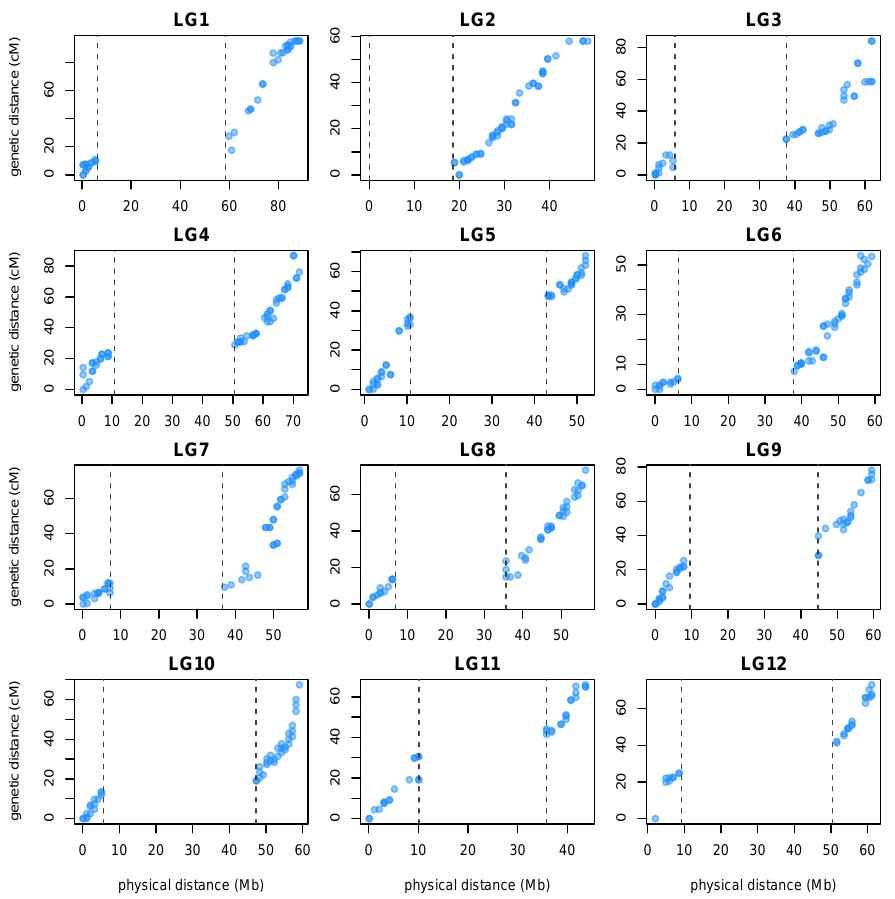
Figure 9. Plot of the genetic location (cM) vs. physical position (Mb) of PotatoMASH loci across the chromosomes. The vertical dotted lines represent the centromeric regions of the